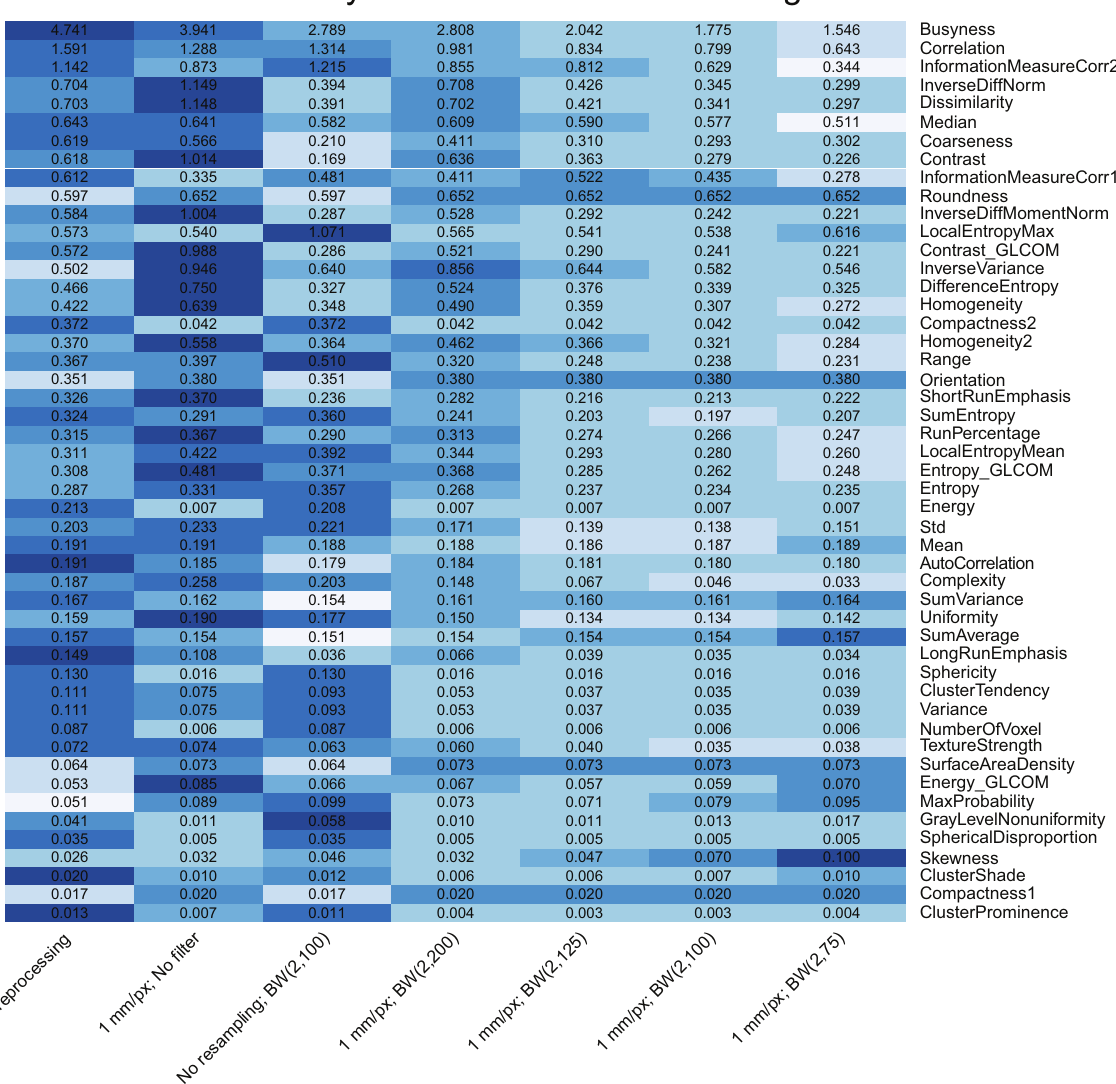
Fig 3. Scaled contrast. Scaled contrast for the CCR phantom’s rubber particle cartridge scannedwith 17 different CT scannerconfigurations. (a) Feature values without image preprocessing. (b) Feature values calculatedafter all images had beenresampledto 1 mm/pixel. (c) Feature values calculatedafter all images had been resampled to 1 mm/pixel and filtered with Butterworth filter (order 2, frequencycutoff 75). The points are color codedand labeledaccordingto the manufacturer of the scanner: GE indicates GE Healthcare(green); P, Philips Healthcare (purple);S, Siemens Healthineers (pink); T, ToshibaMedicalSystems (cyan).